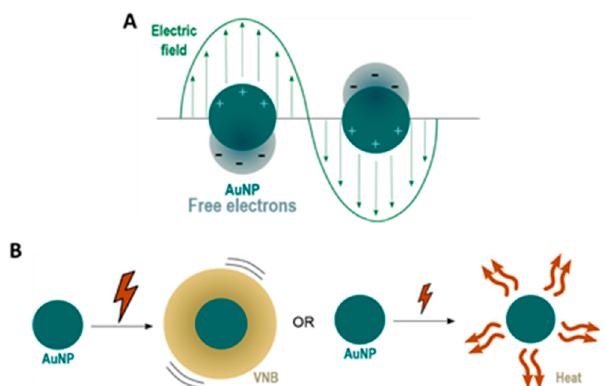
Figure 1. ( A ) under the influence of an external oscillating electromagnetic field, usually provided by laser light, the free electrons of gold nanoparticles (AuNPs) start to oscillate. When the amplitude of this oscillation is maximal, this phenomenon is referred to as Localized Surface Plasmon Resonance (LSPR); ( B ) irradiation of AuNPs with nanosecond laser pulses can lead to the formation of water vapour nanobubbles (VNBs) or heat transfer to the surrounding environment, depending on whether high or low intensity laser pulses are used.